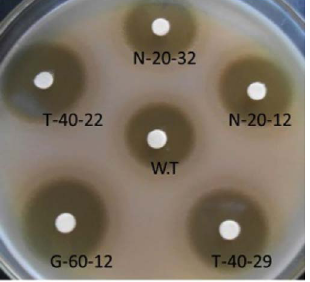
Fig. 1. Neomycin production of S. albogriseolus NRRL B-1305 (W.T) against superior mutant strains of N-20-12, N-20-32, T-40-29, G-60-12 and